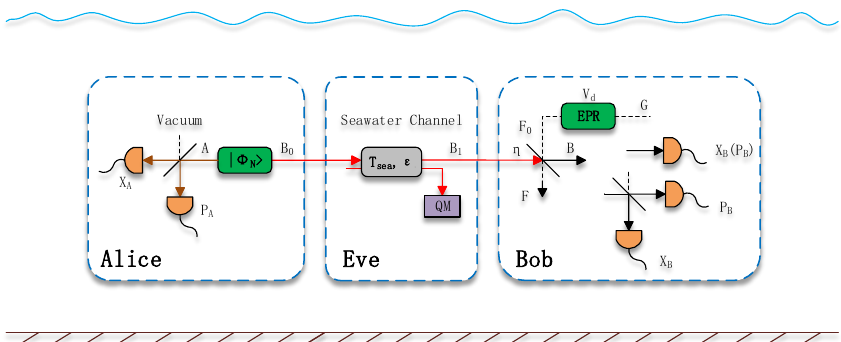
Figure 4. The entanglement-based scheme of the discrete-modulated underwater CV-QKD. Alice randomly prepares one of the N states and sends it to Bob through the untrusted seawater channel. Bob detects the received model to derive a sequence of bits shared with Alice by using a homodyne detector or a heterodyne detector. The seawater channel is assumed to be a linear